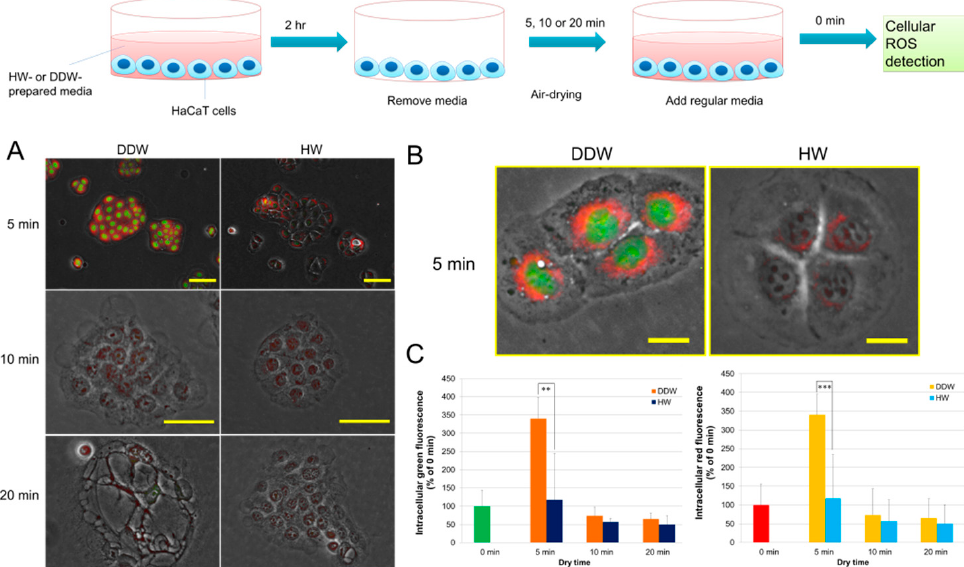
Figure 3. Effects of HW on hypohydration-induced cellular oxidative stress in HaCaT keratinocytes. Cellular ROS was immediately detected as same as in Figure 2. Illustration on the top represents procedures of the experiments. ( A ) Typical fluorescence images of HaCaT cells. Green, nuclei ROS; Red, cytoplasm ROS. Scale bars = 20 µm. ( B ) Scale bars = 10 µm. ( C ) To quantify the cellular ROS, green and red fluorescence in HaCaT cells were analyzed with an Image J software as described in “Materials and Methods”. **, p < 0.01, ***, p < 0.01. Each bar represents the mean ± SD of three independent experiments.